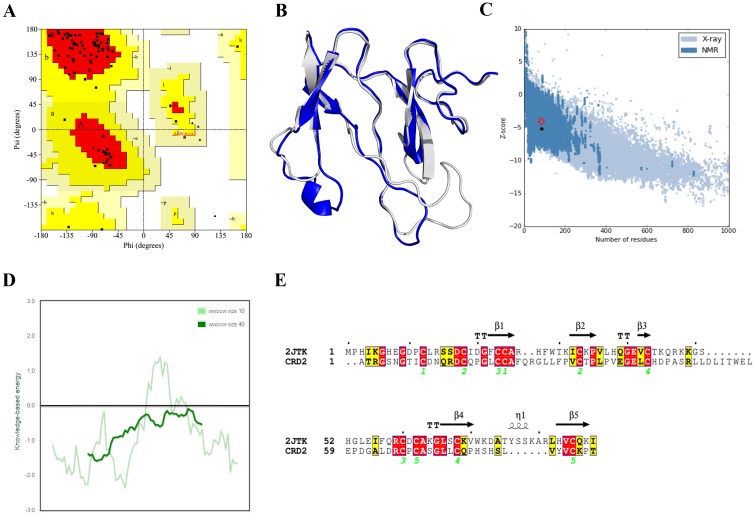
Validation of CRD2 model by several methods.(A) Ramachandran plot. The most favored, additionally allowed, generously allowed and disallowed regions are shown in red, yellow, beige and white colors, respectively. (B) Structural alignment of DKK3C (gray) and 2JTK pdb (blue). (C) ProSA Z-score plot of modeled 3D structure of DKK3C. The position of this model among experimentally solved protein structures is shown in an open red circle. (D) Local model quality by plotting energies as a function of amino acid sequence position. Generally, positive values correspond to problematic parts of the input structure. (E) Sequence and secondary structure alignment of DKK3C and mouse dkk2 (PDB ID: 2JTK) conducted by ESPript 3.0 (http://espript.ibcp.fr/ESPript/ESPript/).